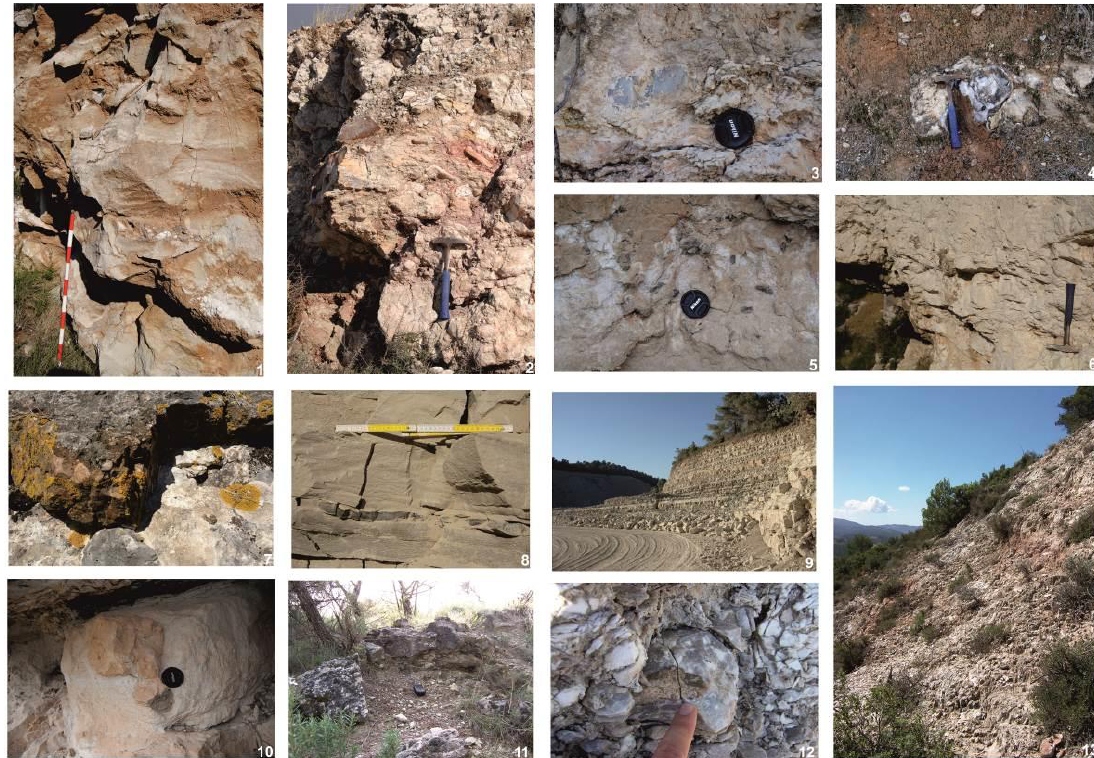
Figure 3. Some of prospected outcrops. Different silicifications enclosed in evaporitic gypsums and red lutites (Valldeperes Fm. [Images 1, 2, 12 & 13] Ulldemolins Complex [3,4] Pira Fm. [5]); and chert nodules enclosed in limestones and dolomites (Bosc d'en Borras Fm. [6], St Miquel Fm [7] Valldeperes Fm. 8, 9, 10&